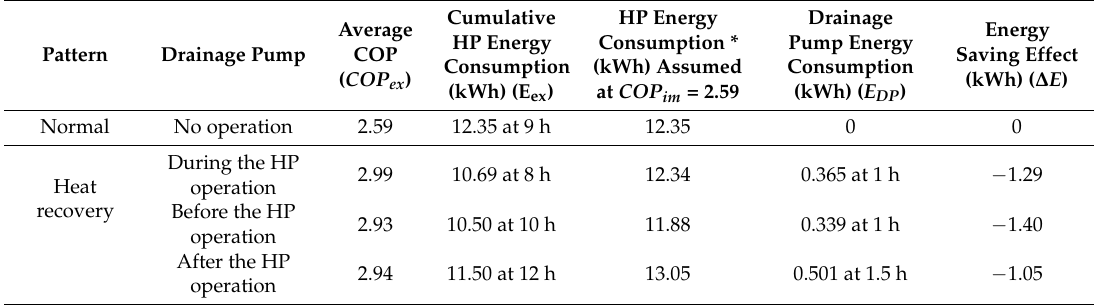
Table 5. Effect of the COP improvement vs the extra electric power consumption for the drainage pump.